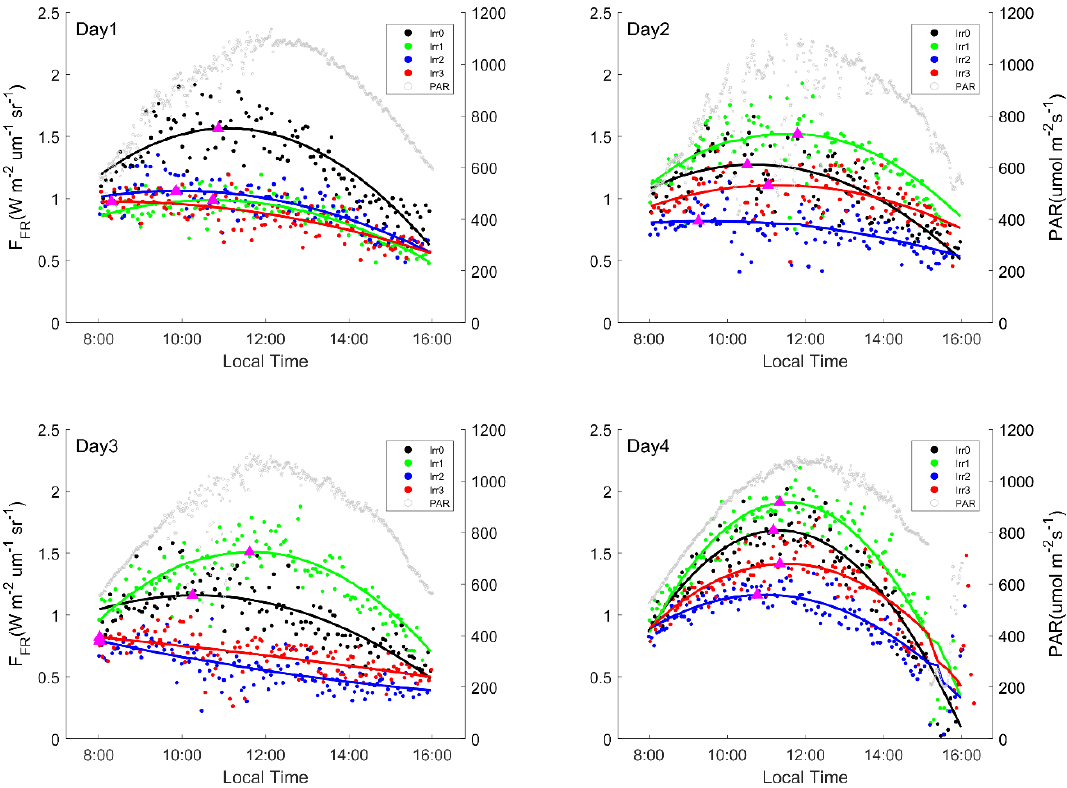
Figure 2. Diurnal far red fluorescence (F FR ) data, with Day1 to Day4 representing the 4 observation dates (30 July, 31 July, 3 August, 4 August). Scatter points represent measured data, and the solid line represents fitted data of Sun-induced Fluorescence (SIF). Magenta triangles represents peak value of fitted data. On the evening of Day1, Irr1 and Irr3 were watered 0.3 m 3 and 0.16 m 3 , respectively. On the evening of Day3, Irr0, Irr1, Irr2, and Irr3 were watered 0.4 m 3 , 0.2 m 3 , 0.3 m 3 , and 0.16 m 3 , respectively.